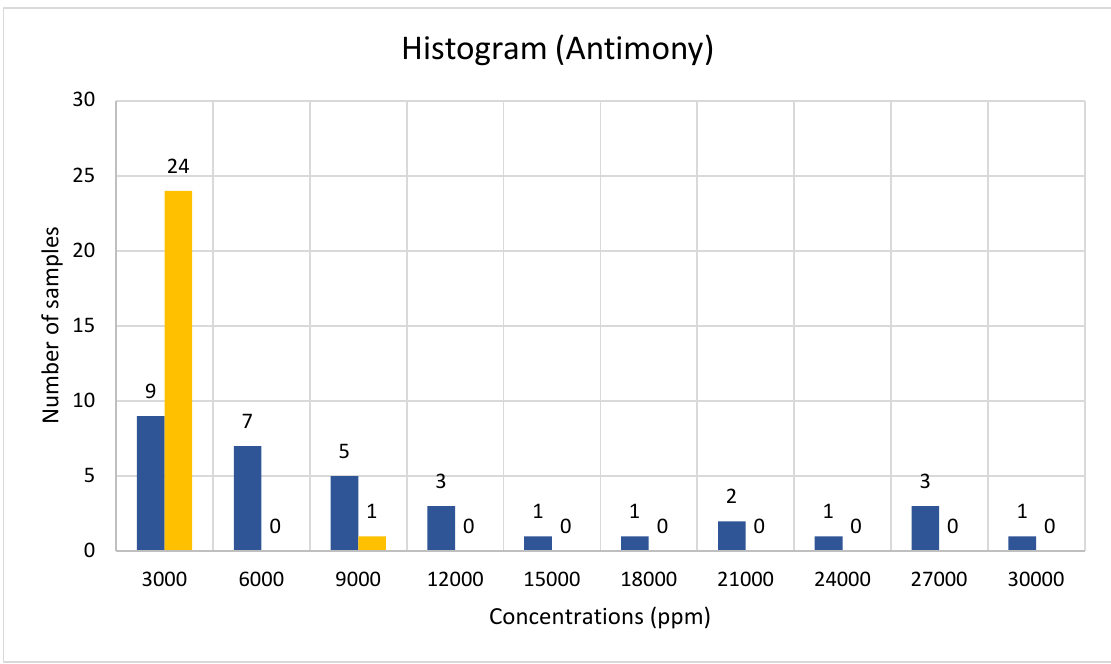
Figure 6. Histogram of antimony concentrations (mining area in blue and waste rock in orange).